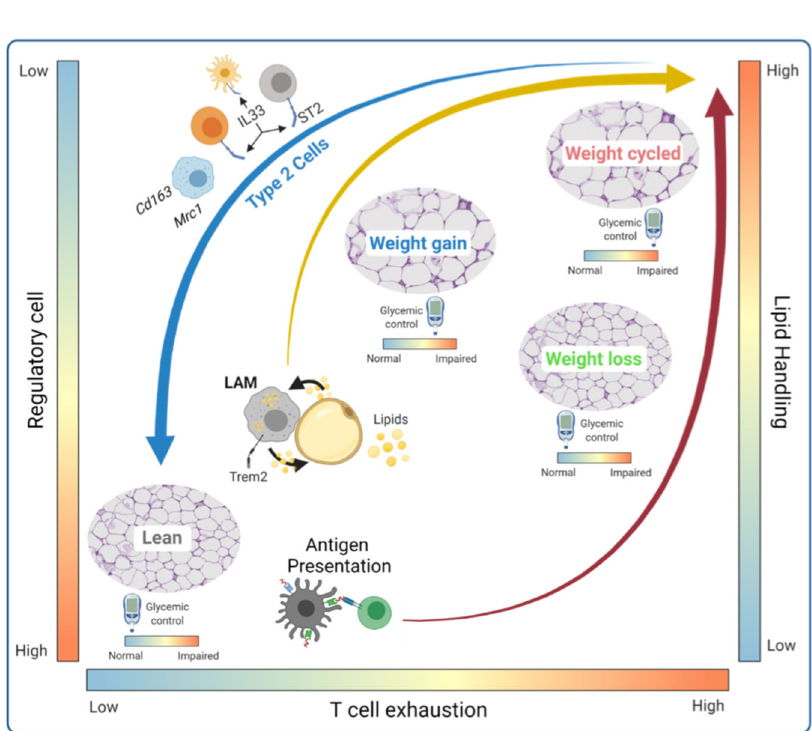
Fig. 7 Adipose tissue immune remodeling during WL and WC. Body weight gain results in a transition from abundant type 2 immune cells cells (type 2 innate-like lymphoid cells, regulatory T cells, and tissue resident macrophages) present in lean adipose tissue towards an accumulation of immune cells/ phenotypes associated with lipid handling (lipid-associated macrophages, LAMs) and antigen presentation. WL does not restore the antigen presentation phenotype and is associated with T cell exhaustion. T cell exhaustion and LAMs are further ampli fi ed by weight regain. There is a disconnect between systemic glucose homeostasis and immune remodeling in adipose tissue, such that WL corrects obesity-induced glucose intolerance, but does not resolve the altered immune cell composition caused by diet-induced